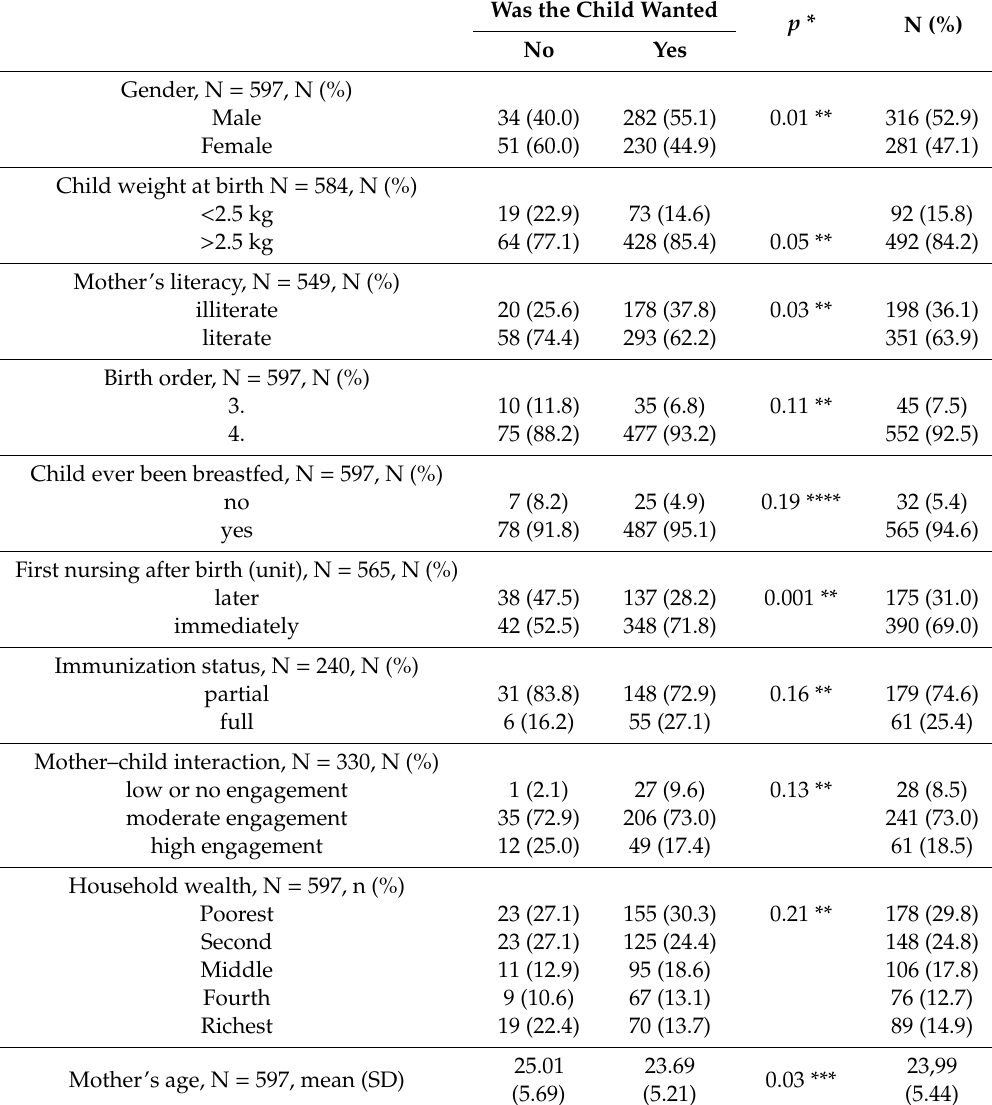
Table 1. Sociodemographic and parental investment measures distribution based on Roma children